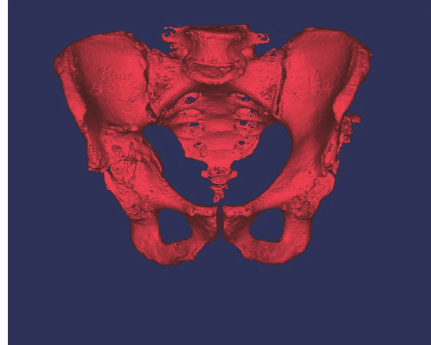
Figure 8: Thresholding and segmenting (deleting) the femoral bones from the pelvis.